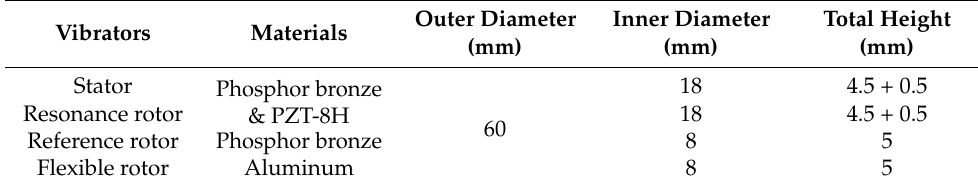
Table 1. Material composition and structural parameters of stator and rotors.